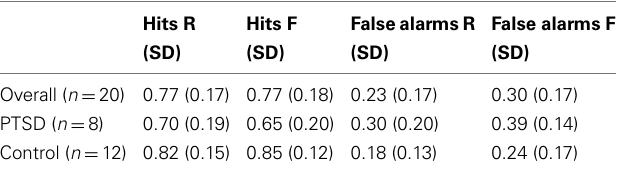
Table 1 | Mean hit and false alarm rates in the R and F conditions for the whole sample as well as separately for the PTSD and control group.